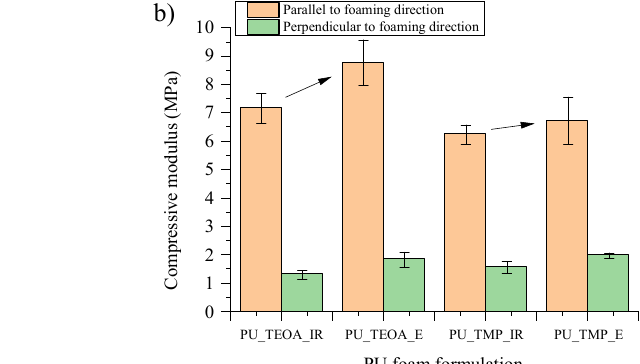
Table 5. The common characteristic of developed rigid PU foams comparison with other materials.